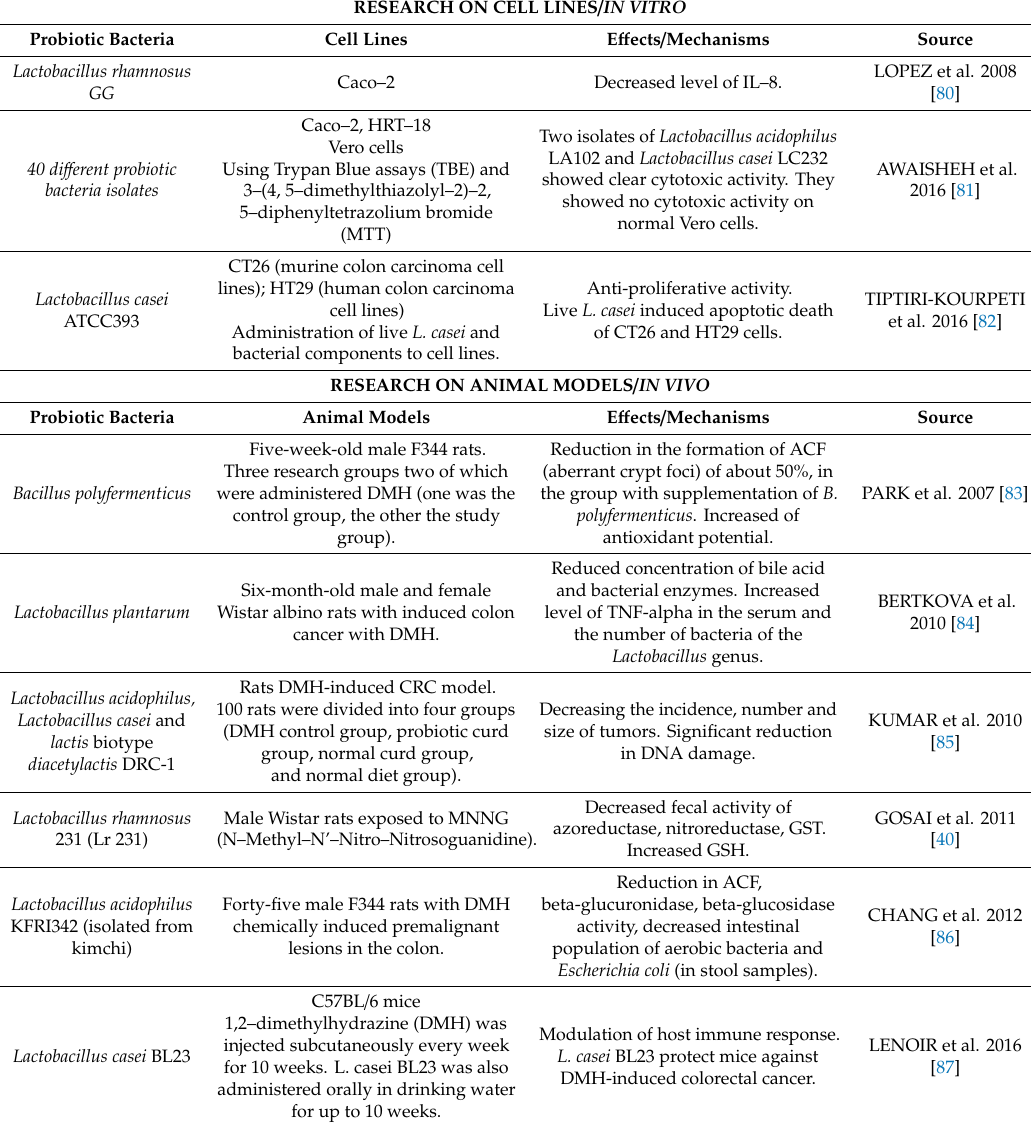
Table 2. The impact of probiotic bacteria on cancer cell lines and on animals with induced colorectal